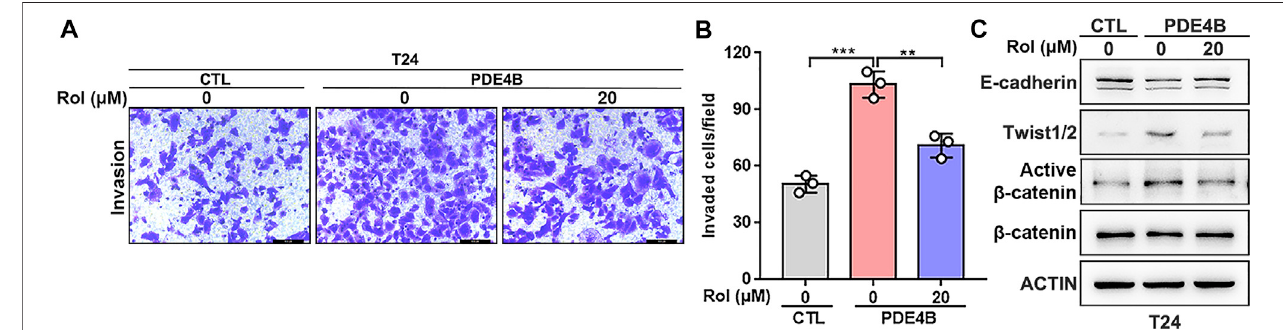
FIGURE 8 | Rolipram suppresses UBC invasion via inhibiting the PDE4B activity. (A,B) PDE4B overexpression enhanced cell invasive ability, whereas this effect waspartlyabolishedbyRolipram(Rol)atdoseof20 μ M.Scalebar,100 μ m. (C) GeneexpressionwasexaminedbywesternblottinginPDE4B-overexpressingcellsafter treated with Rol at dose of 20 μ M ** p < 0.01, *** p <